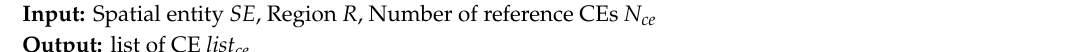
Algorithm 4: The FSAInference